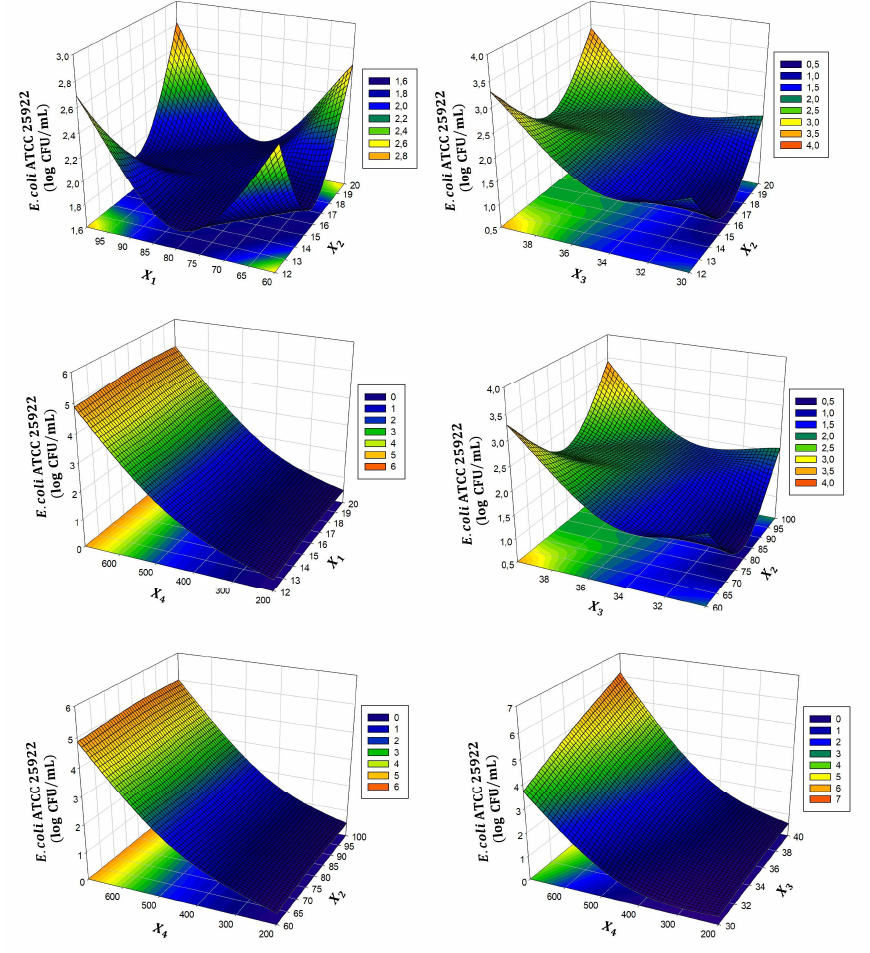
Figure 1. Three-dimensional response surface plots showing the influence of process factors on E. coli ATCC 25922: (X 1 ) ultrasound time (min); (X 2 ) ultrasound amplitude (%); (X 3 ) microwave time (s); (X 4 ) microwave power